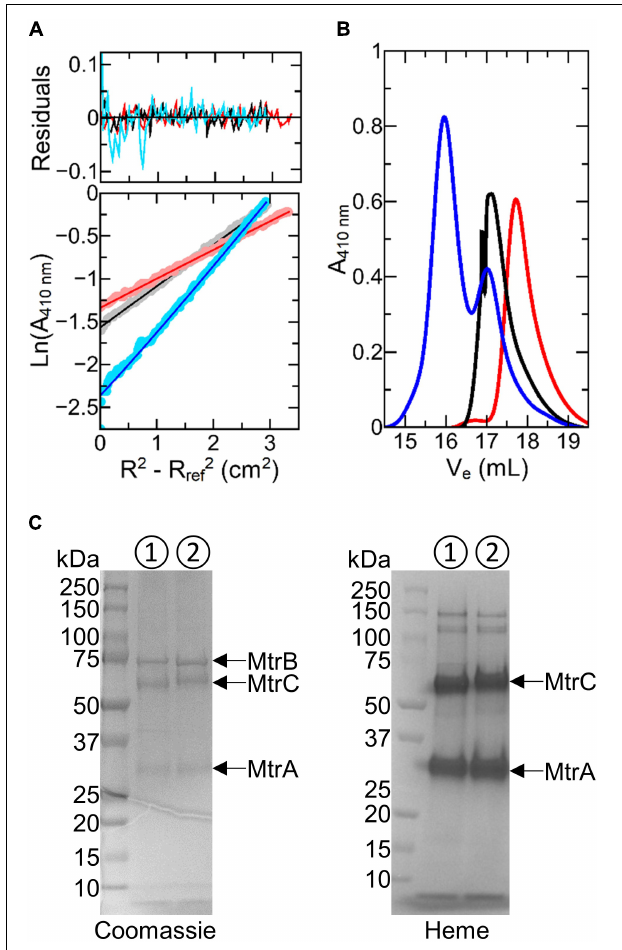
FIGURE 2 | Biophysical characterization of Ru-MtrC:MtrAB. (A) Sedimentation equilibrium analytical ultracentrifugation traces for 0.4 µ M MtrAB (black), 0.4 µ M Ru-MtrC (red), and a mixture of 0.25 µ M Ru-MtrC equilibrated with 0.25 µ M MtrAB (blue). Samples were centrifuged at 8,000 rpm for 20 h at 20 ◦ C in 50 mM sodium phosphate, 50 mM NaCl, and 0.1% ( v / v ) Triton X-100, pH 7.5 to reach equilibrium. Lower panel: data (circles) and fits (lines) to the behavior for a single non-interacting species; see text for details. Upper panel: residuals. (B) Gel filtration chromatograms for samples of 40 µ M MtrAB (black), 40 µ M Ru-MtrC (red), and a mixture of 32 µ M Ru-MtrC equilibrated with 48 µ M MtrAB (blue). A Superose 6 Increase 10/300 column was equilibrated in 50 mM sodium phosphate, 50 mM NaCl, and 5 mM LDAO, pH 7.5. Elution was at 0.25 ml min − 1 . (C) SDS-PAGE analysis of the MTR complex ( (cid:192) ) and Ru-MtrC:MtrAB ( (cid:193) ) ( V e < 16.5 ml from gel filtration shown in (B) ). Proteins visualized by Coomassie and Heme stain as